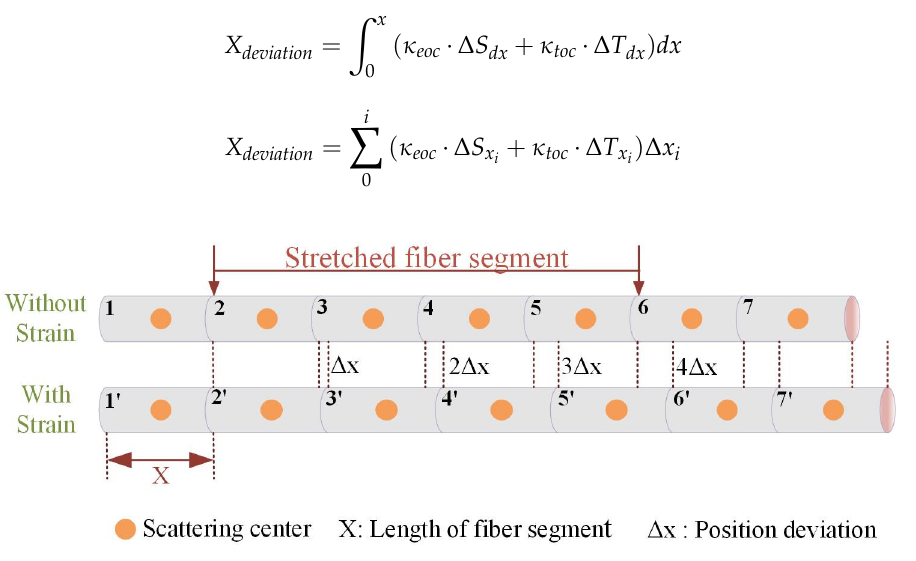
Figure 2. Distribution of scattering center along sensing fiber before and after strain.